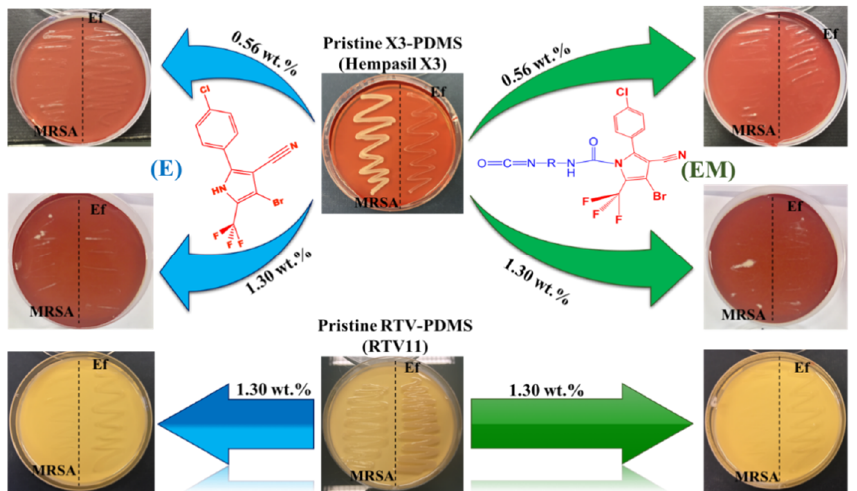
Figure 2. Antimicrobial susceptibility against MRSA and E. faecalis (Ef) of polydimethylsiloxane (PDMS)-based coatings, X3-PDMS, and RTV-PDMS, containing incorporated Econea, E (left side), and grafted Econea, EM (right side), at different biocide contents, 0.56 wt.% and 1.30 wt.%.